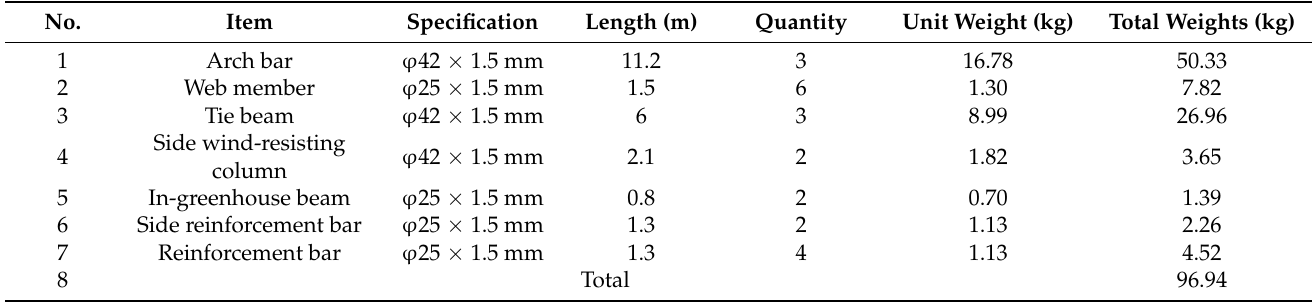
Table 1. Components of the multi-arch greenhouse.